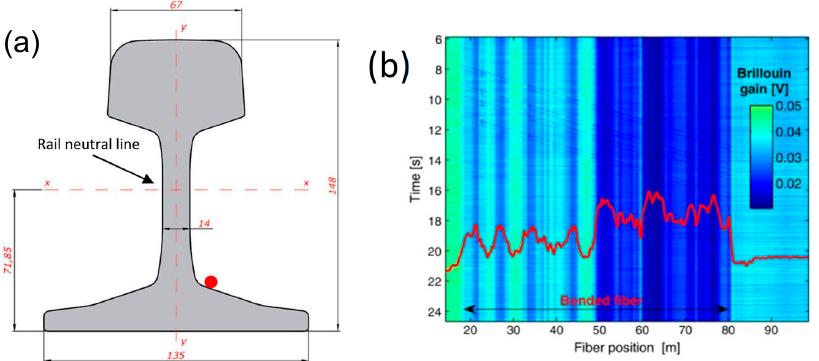
Figure 14. ( a ) Cross-section of the rail, also indicating the position of the glued fiber (red dot), and ( b ) Brillouin gain map as a function of time and position. The superimposed red curve represents the acquired Brillouin frequency shift profile (from Ref. [139]).